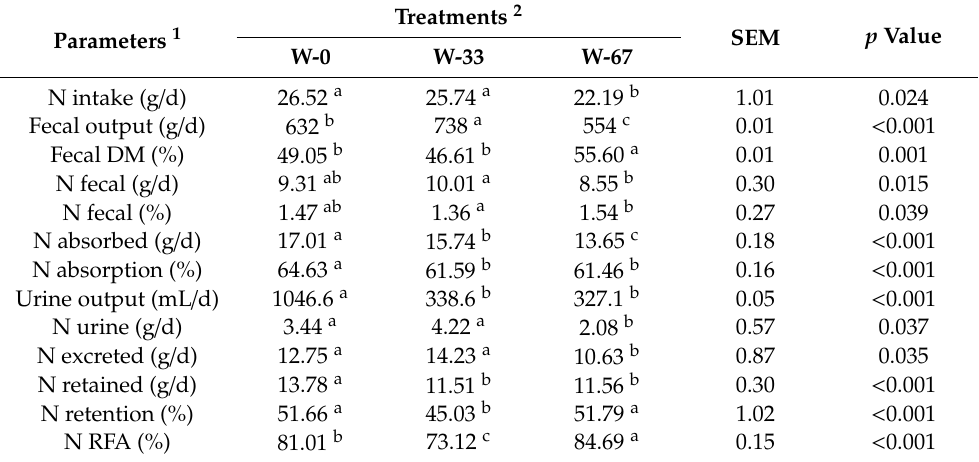
Table 3. Nitrogen metabolism in water-restricted male Najdi lambs fed a pelleted diet. Treatments 2 Parameters 1